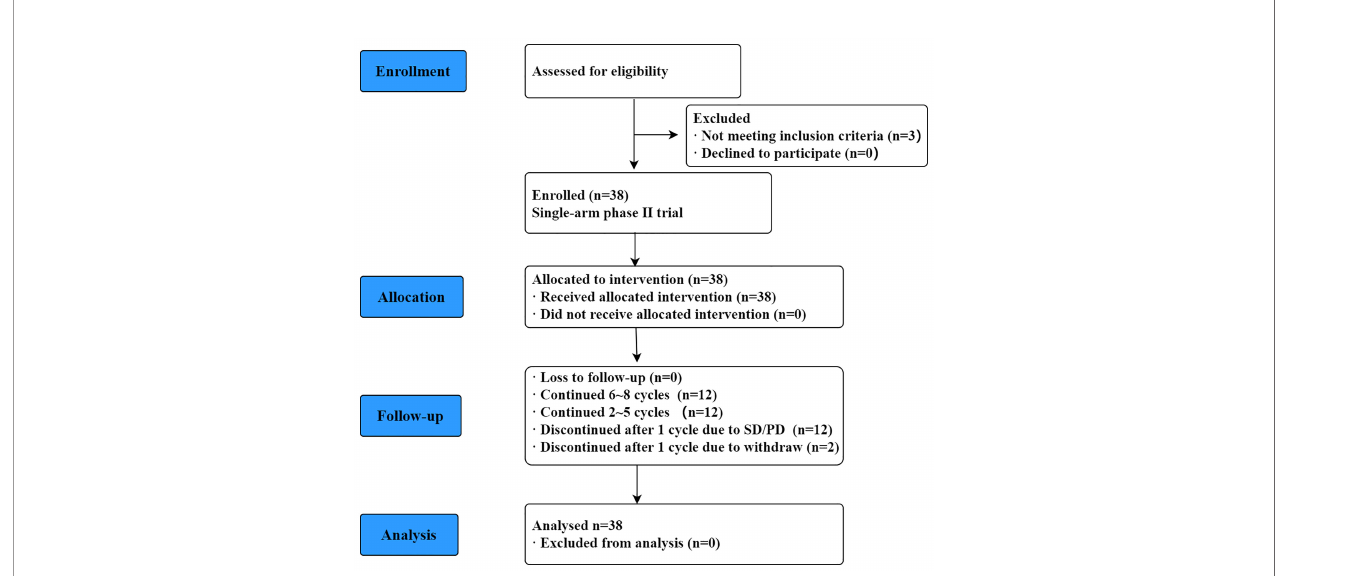
FIGURE 1 | CONSORT fl owchart of R/R PCNSL patients in the